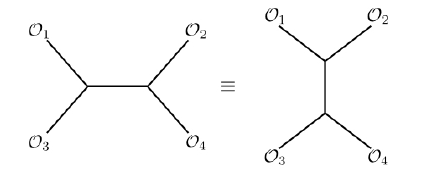
Figure 1 . Crossing relations for the scattering amplitude in dual